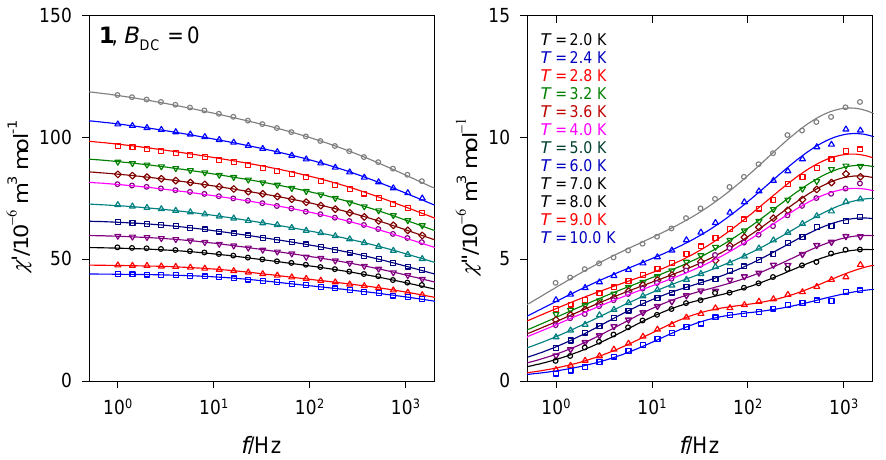
Figure 7. The frequency dependence of the AC susceptibility for 1 . Solid lines — fitted. Temperature evolution of the (fitted) relaxation time, individually for the LF and HF relaxation channels, is presented in Figure 8. It can be seen that the HF relaxation time below 8 K is almost temperature independent, which indicates a quantum tunnelling relaxation process.